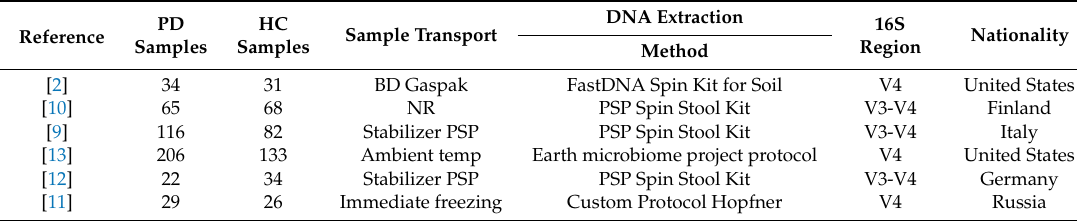
Table 1. List of references, number of samples, methodological approaches and nationality of studies considered in this